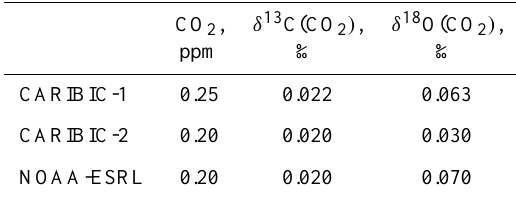
Typical combined uncertainty (1- σ values) of the CARIBIC-1 and CARIBIC-2 CO 2 measurements and for measure- ments at NOAA-ESRL (Conway et al., 2009; White and Vaughn,